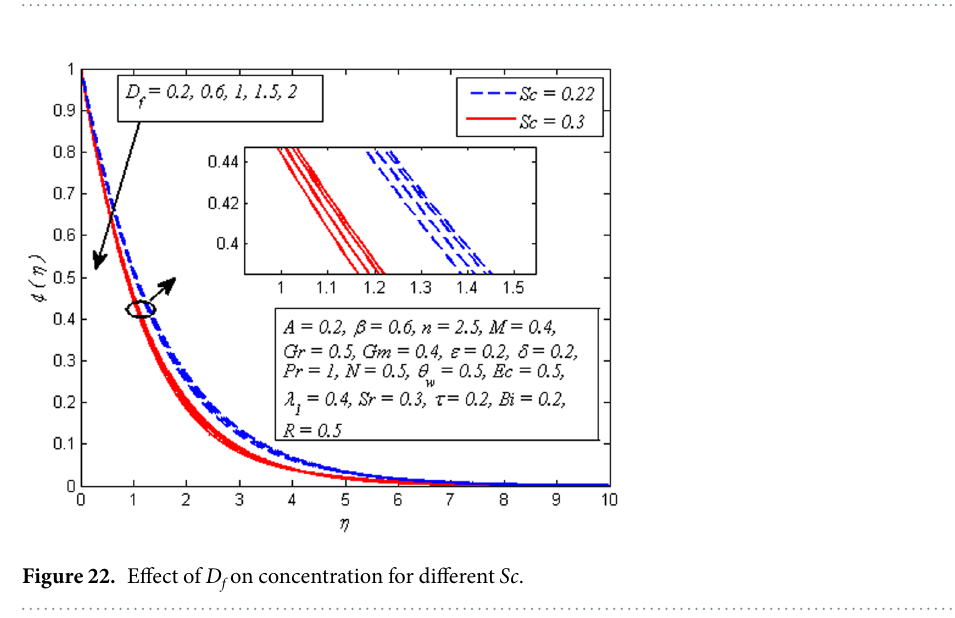
Figure 21. Effect of Sr on concentration for different Sc .